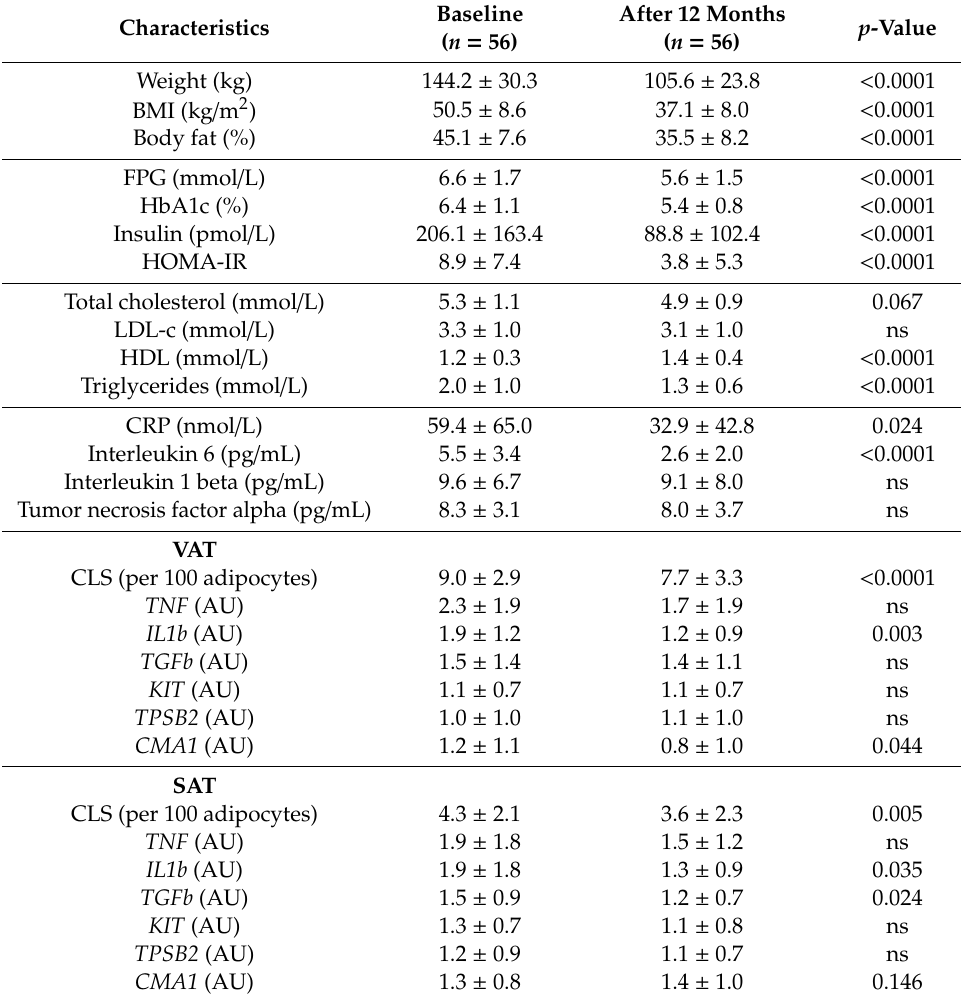
Table 3. Changes in clinical and inflammatory markers and AT genes, 12 months following bariatric surgery in validation cohort 2. Values are mean ± SD. CLS—crown-like structures, VAT—visceral adipose tissue, SAT—subcutaneous adipose tissue. ns—not significant ( p >